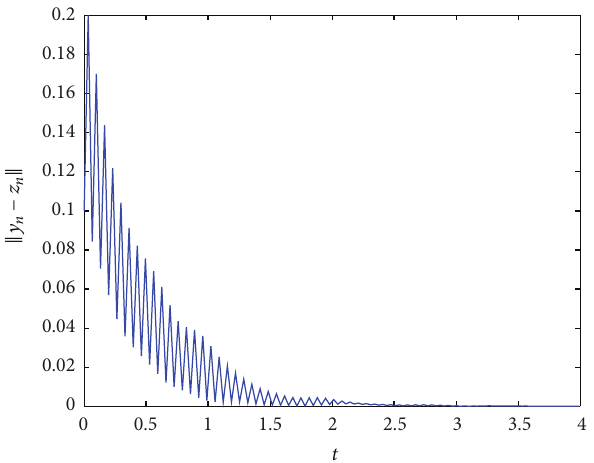
Figure 1: The norm of difference ‖𝑦 𝑛 − 𝑧 𝑛 ‖ with step size ℎ = 0.033 .